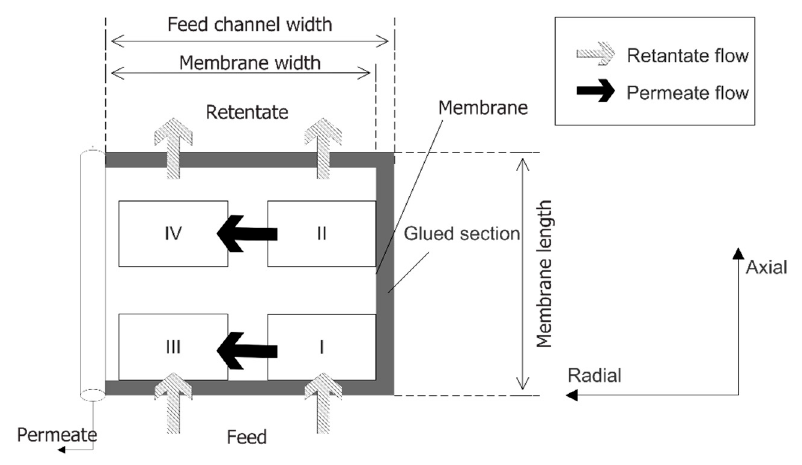
ends as it covers the entire membrane module.